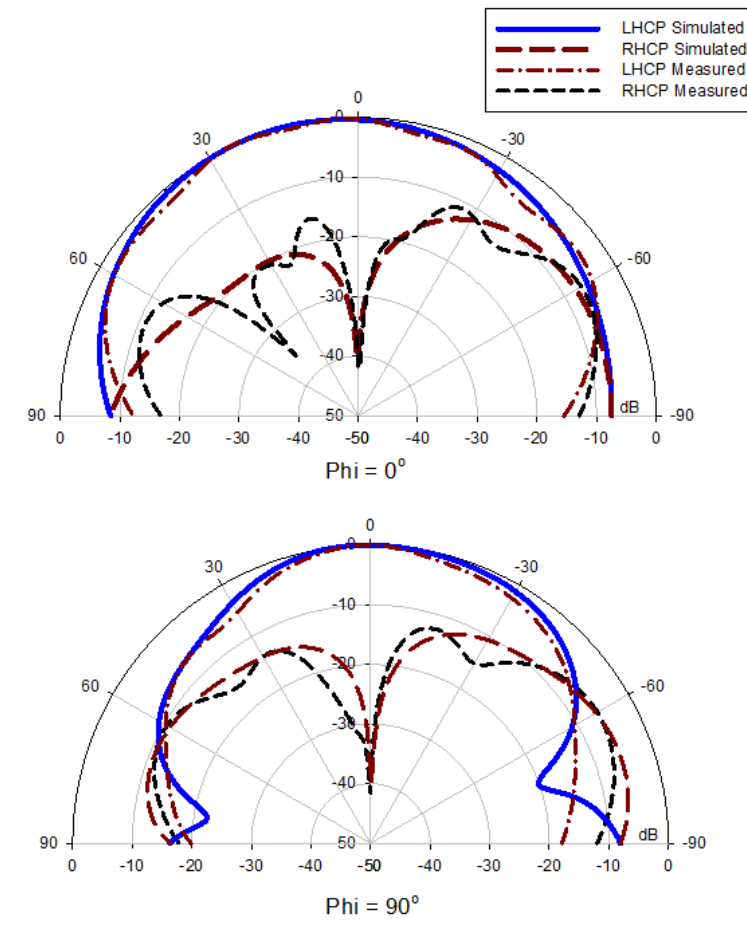
Figure 14. Radiation patterns of the proposed antenna at 3.7 GHz.